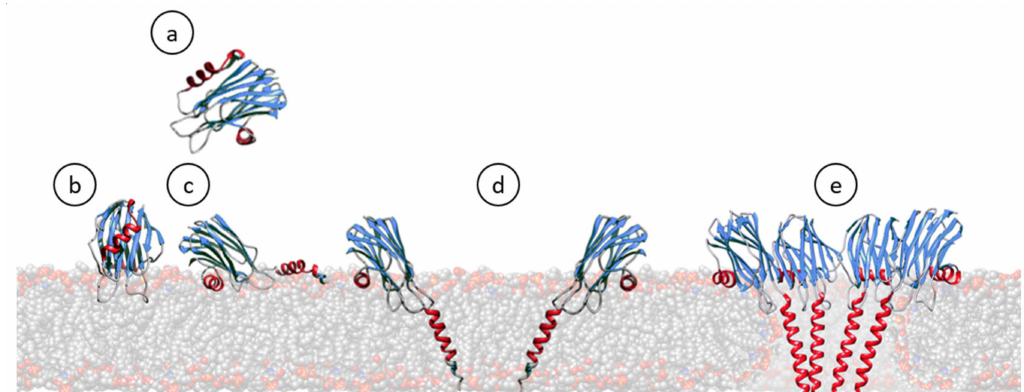
Figure 3. Cartoon schematic representation showing most of the steps generally accepted for the pore formation mechanism of actinoporins. In solution, they remain soluble and stably folded ( a ) [26,110,124,127,136–139]. Upon interaction with a lipid membrane containing SM ( b ), their N-terminal α -helix stretch is detached and extended, shortly laying parallel to the membrane ( c ) [25,26,82,85,87,91,116,140–143]. Then, monomers oligomerize and insert this N-terminal α -helix, now about 30 residues long, within the hydrophobic membrane core ( d ) [34,144–149]. The existence of such an intermediate is one of the most controversial issues, depending on the degree of acceptance of the evidence about the real existence, or not, of pre-pore assemblies [132,133,150]. Finally, a cation selective channel is established ( e ) [39,116,128,136,144,151].